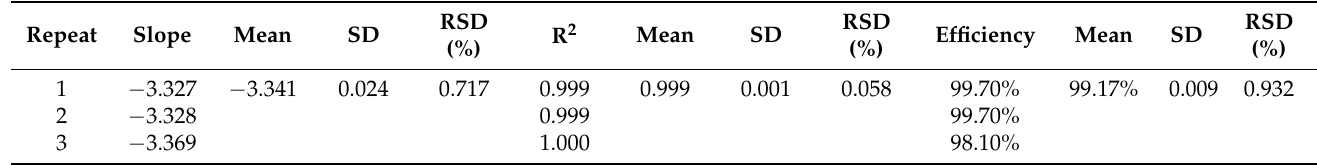
Table 2. Repeatability of characteristic parameters of standard curves from